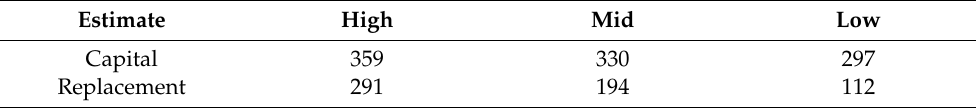
Table 3. Turnkey lithium-ion battery cost sensitivities (in $/kWh)